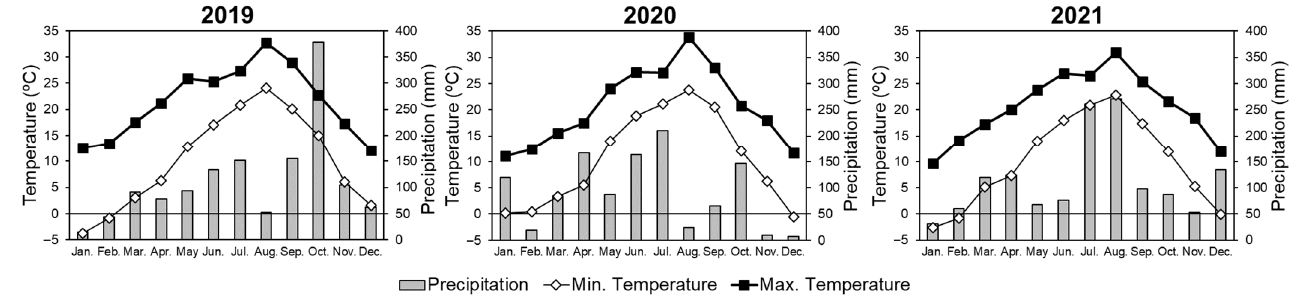
Figure 2. Monthly precipitation and minimum and maximum temperatures at the FFPRI, Ibaraki, Japan (from 2019 to 2021). Japan (from 2019 to